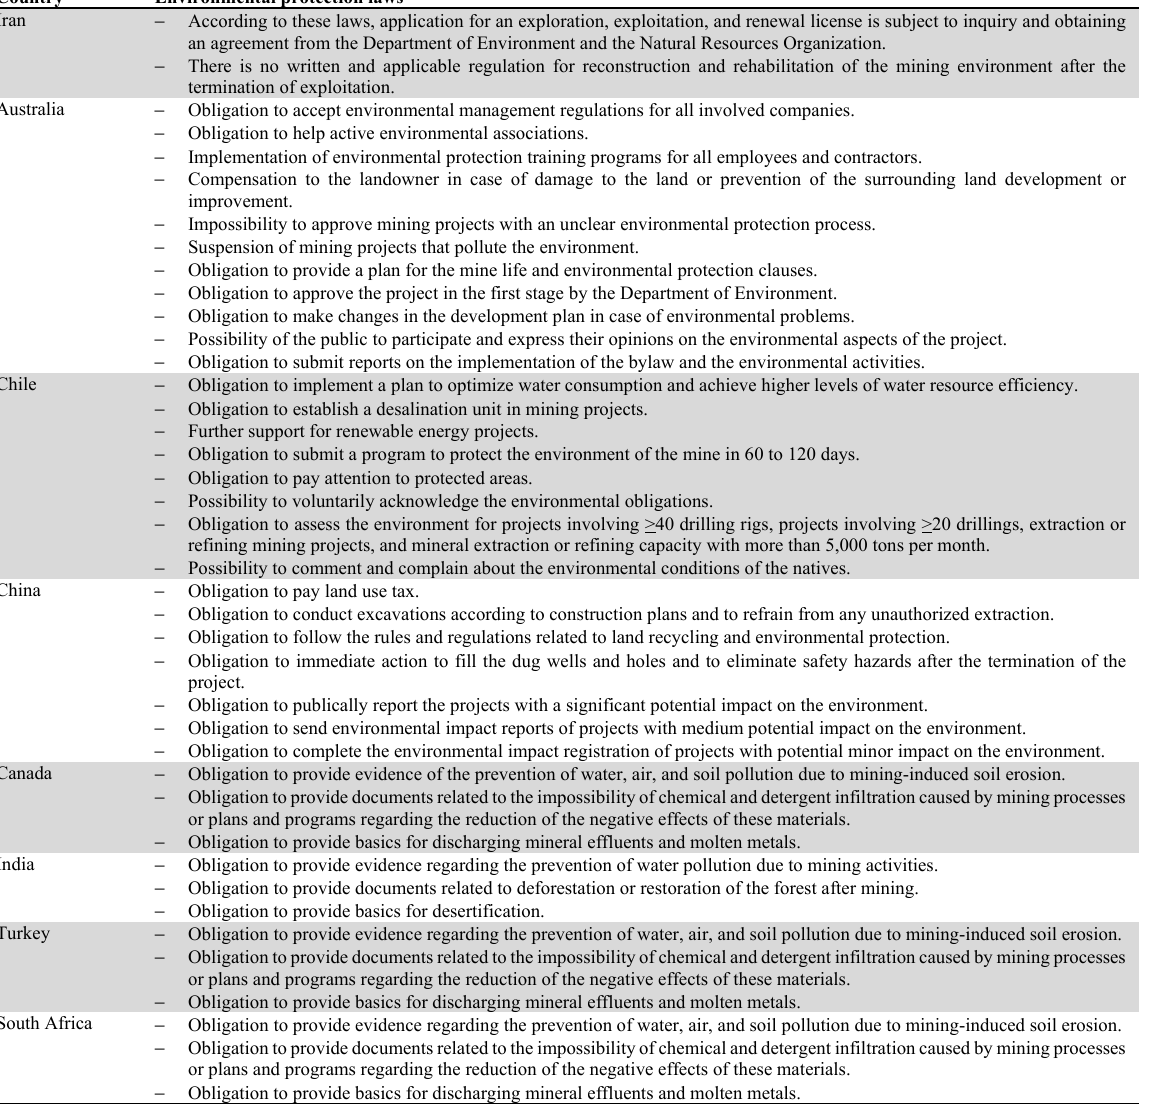
Environmental protection laws